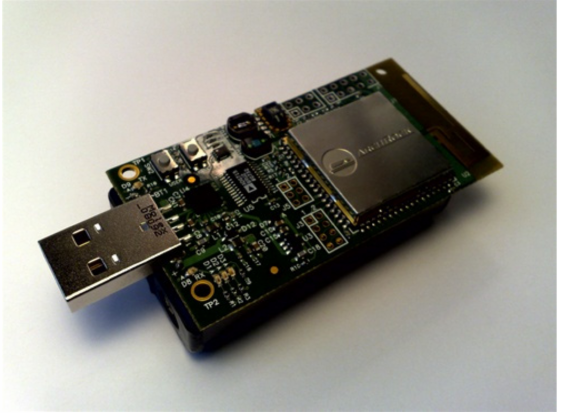
Figure 7. Pictorial description of Epic [161].